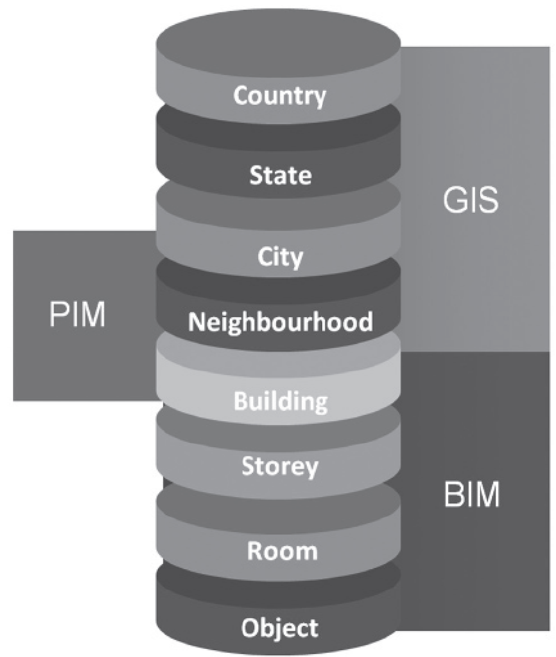
Figure 1. Spatial information platforms for the built environment (Source: ref.